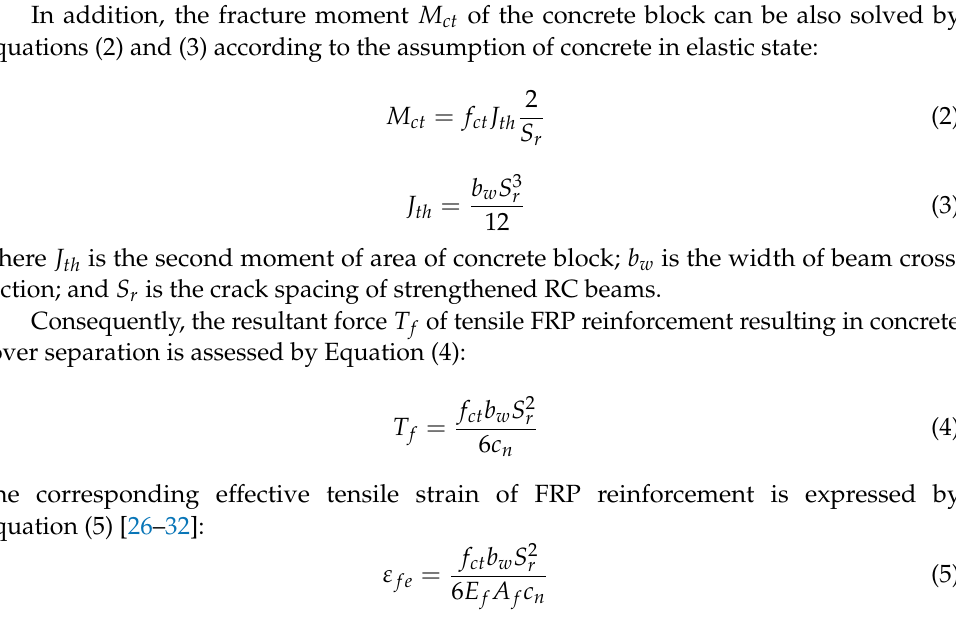
Figure 2. Concrete tooth model for end concrete cover separation: ( a ) mechanical model; and ( b ) concrete cover separation.